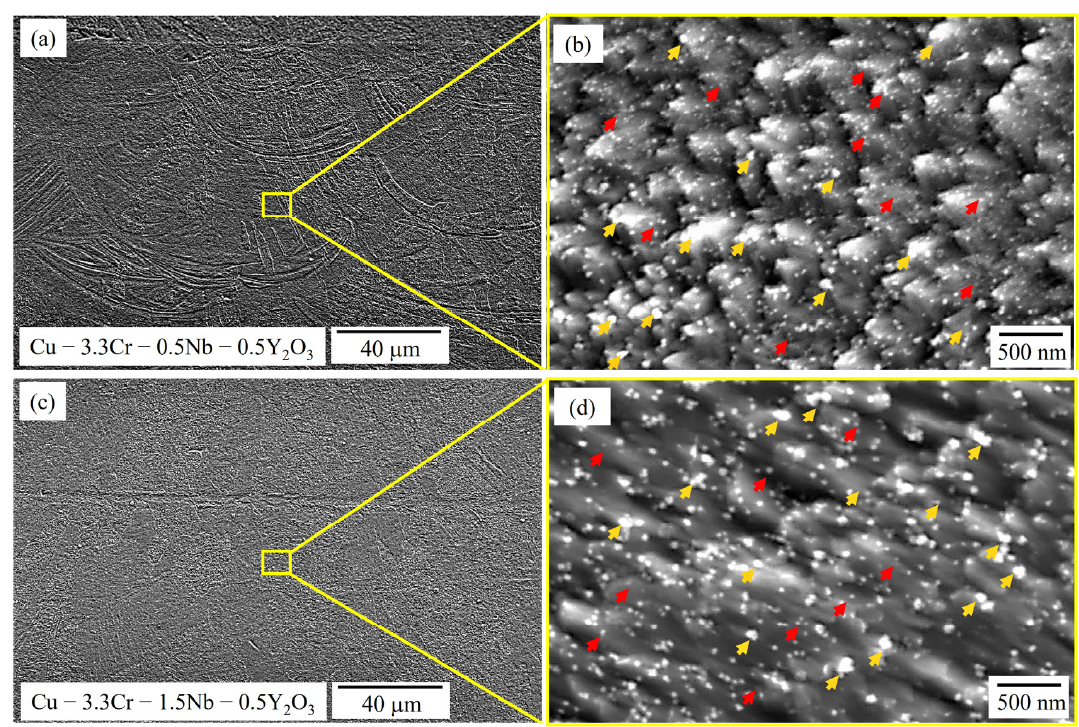
Figure 6. SEM images of oxide-reinforced Cu-3.3Cr-0.5Nb alloy in low ( a ) and high magnification ( b ) showing the presence of precipitates (red arrows) and dispersoids (yellow arrows). SEM images of oxide-reinforced Cu-3.3Cr-1.5Nb alloy in low ( c ) and high magnification ( d ) showing the presence of precipitates (red arrows) and dispersoids (yellow arrows). Table 5. Chemical composition (in wt.%) of reinforced specimens determined by EDS. Values are averaged over 12 single-point measurements on occasionally found clusters or larger particles of the respective nanoparticle species.